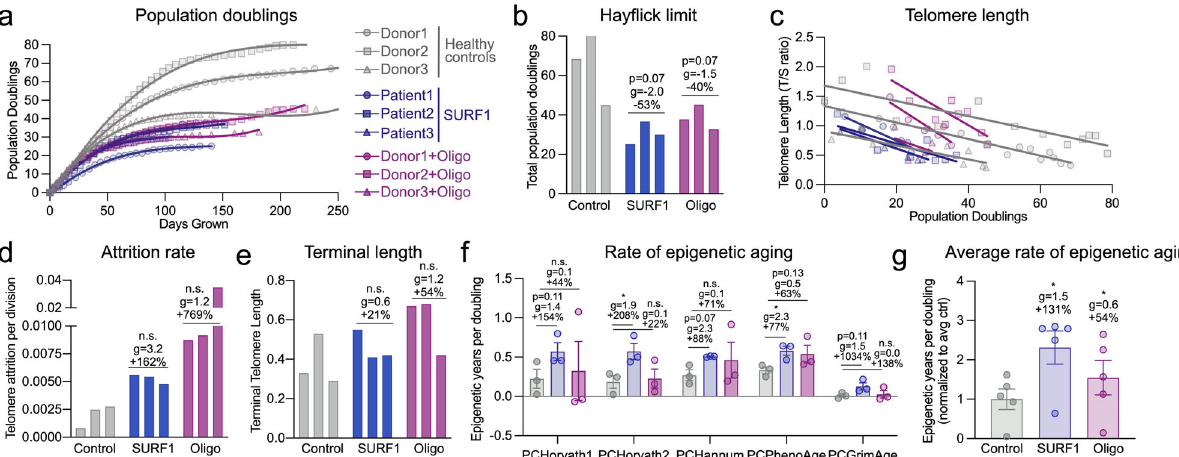
Fig. 8 Mitochondrial OxPhos defects decrease lifespan and accelerate telomere shortening. a Growth curves of control, SURF1, and Oligo-treated cells. Population doublings were determined from both live and dead cell cells at each passage. b Hay fl ick limit de fi ned as the total number of population doublings achieved before division rate <0.01 divisions/day for at least two passages. c Telomere length per population doubling, d rate of telomere attrition per division, and e terminal telomere length. f Rate of epigenetic aging for control, SURF1, and Oligo-treated cells, calculated from the linear rate between days 25 and 75 (3 – 4 timepoints/cell line). g Average rate of epigenetic aging across all PC-based clocks. Each datapoint represents a different clock. f , g Signi fi cance values were calculated using a multiple comparison two-way ANOVA. n = 3 donors per group, 5 – 15 timepoints per condition for telomere length. In d , data are the slope estimate for the linear regressions in ( c ). Data are means± SEM. * P < 0.05, ** P <